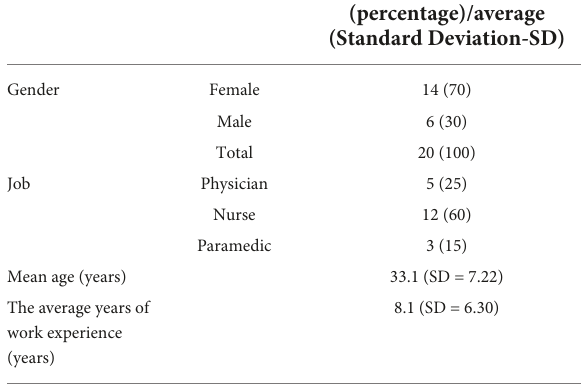
TABLE 1 Demographic characteristics of study